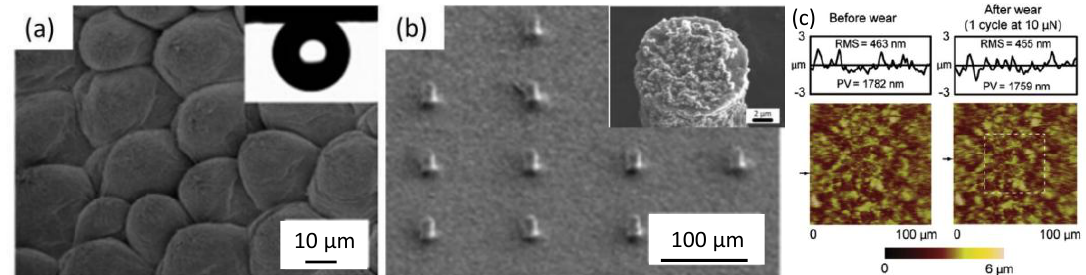
Figure 12. ( a ) Bio-inspired rose petal structure with strong adhesion [124]; reproduced with permission from the American Chemical Society. ( b ) Hierarchical micro-/nano-pillar showing superhydrophobicity and strong adhesion [123]. ( c ) Wear test performed by AFM [123]; reproduced with permission from Elsevier.